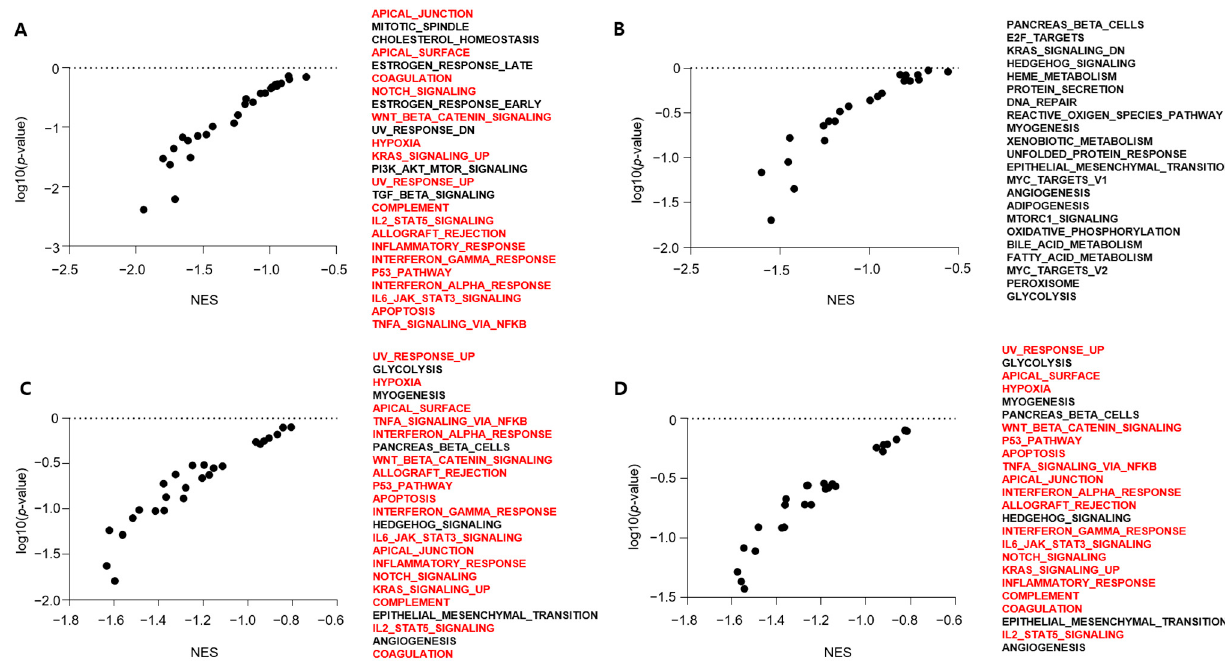
Figure 4. Results of GSEA according to patients’ age, FAL1 upregulation and ECM1 upregulation. ( A )Representative gene sets co-ordinately enriched in the young patient group. ( B ) Representative gene sets co-ordinately enriched in the old-aged group. ( C ) Representative gene sets co-ordinately enriched in the FAL1 -upregulated group. ( D ) Representative gene sets co-ordinately enriched in the ECM1 -upregulated group. Red colour refers to gene sets overlapping in the young-aged group and the FAL1 - and ECM1 -upregulated group. Abbreviations: GSEA, gene set enrichment analysis; NES, normalised enrichment score.